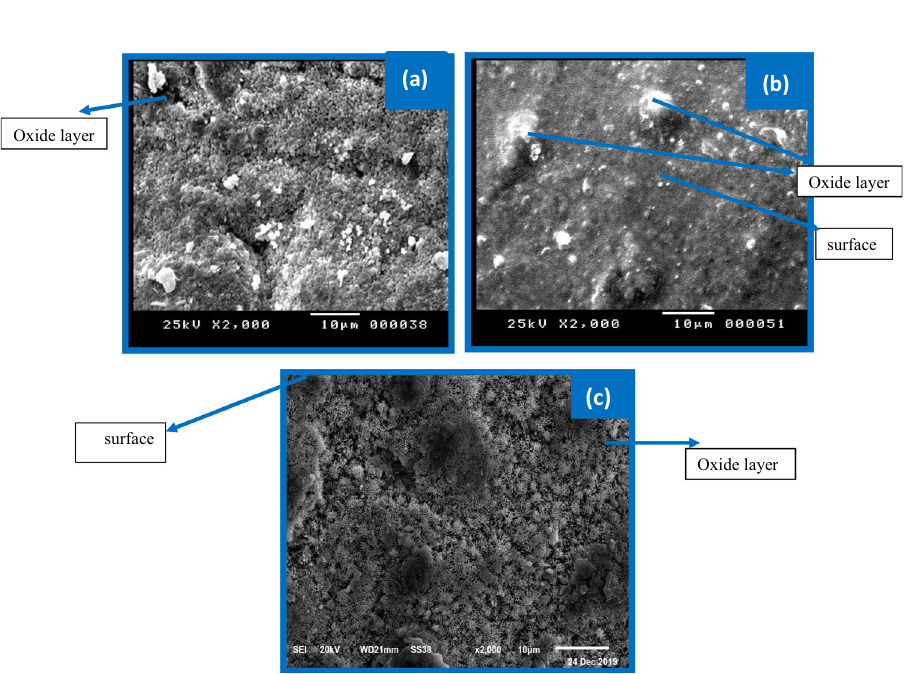
Figure 11. Captured images of SEM for the generated film of pristine zinc Zn ( a ), and its alloys I ( b ), and II ( c ) at + 0.8 V in the 6 M KOH